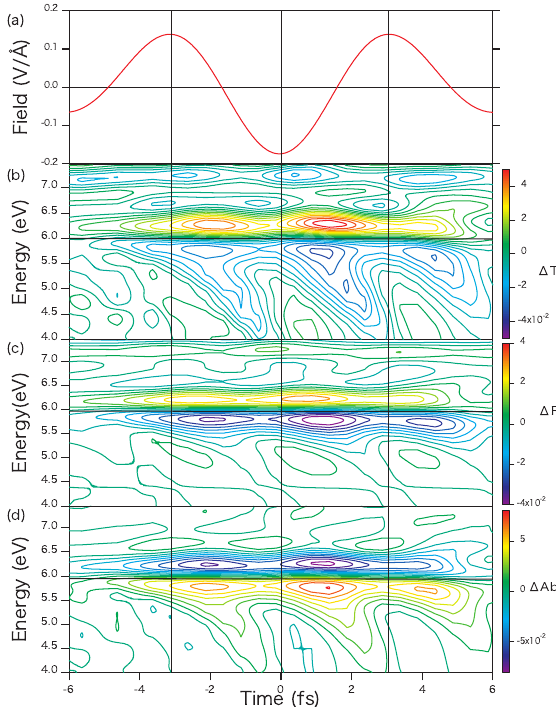
Figure 4. The laser field amplitude is shown in ( a ). Time-energy map of the ( b ) ∆ T , ( c ) ∆ R , and ( d ) ∆ Ab under the pump laser intensity of 4 × 10 11 W/cm 2 . The time 0 is set to the peak of the laser intensity at diamond